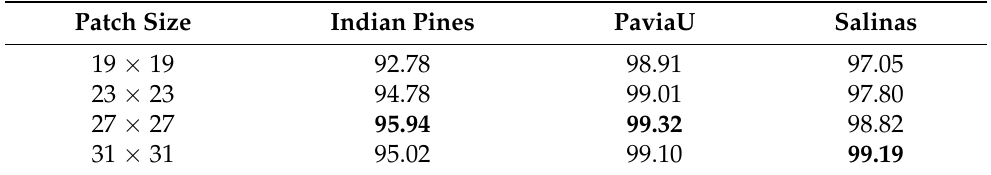
Table 4. Overall accuracy of different patch sizes in the Indian pines, PaviaU, and Salinas data sets.